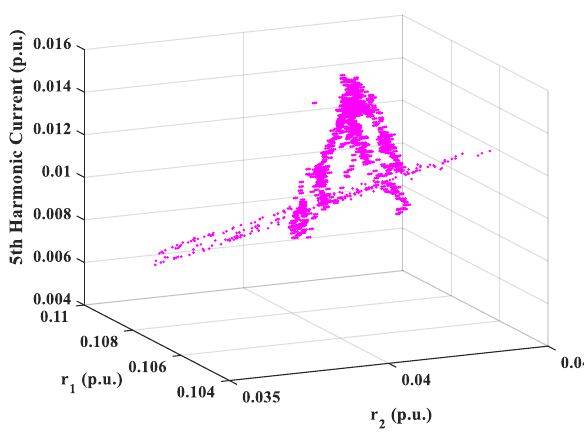
Figure 3. Dataset of case 1.